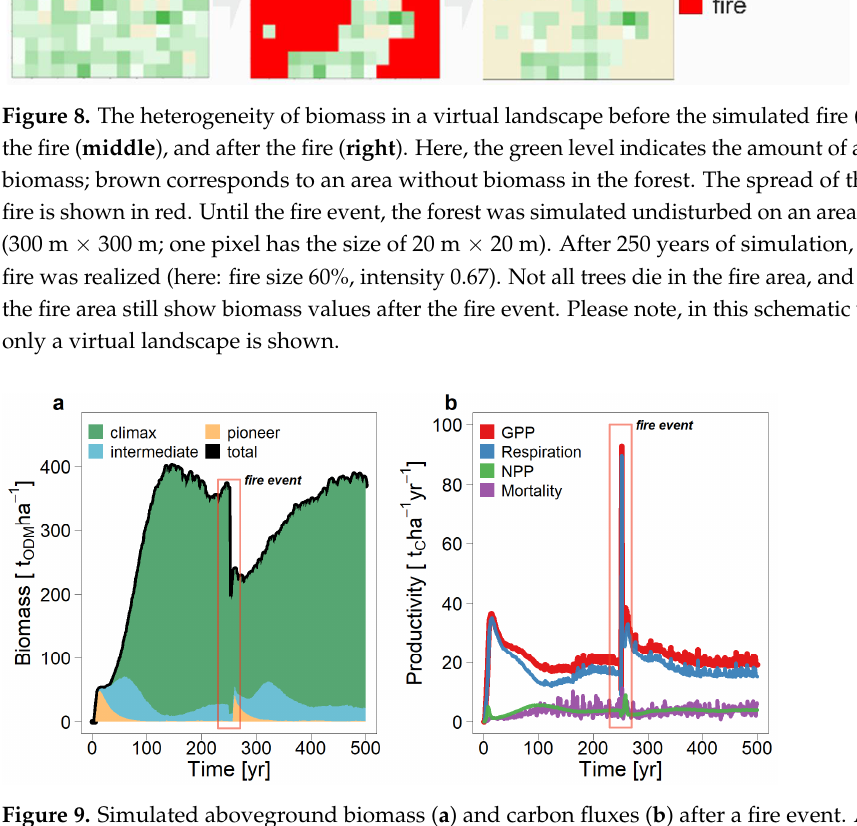
fire was simulated in the year 250. The development of aboveground biomass per shade-tolerance is